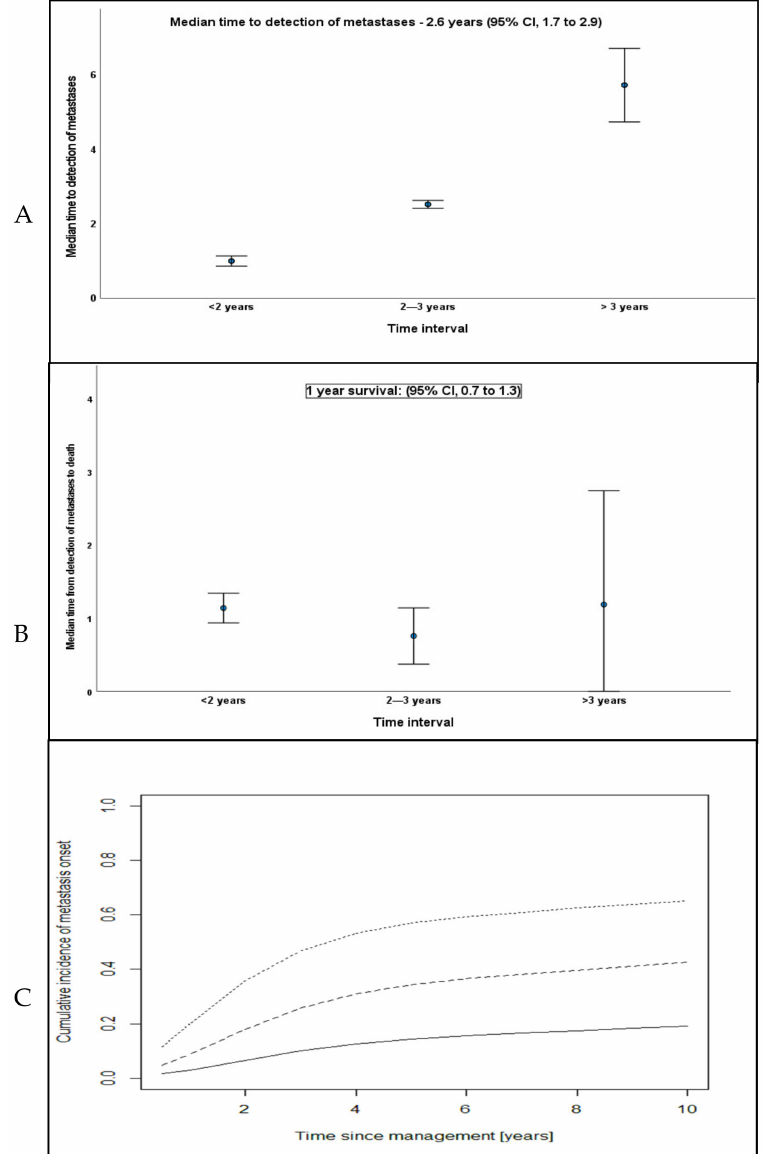
Figure 3. Bar charts with estimates for all 150 patients with metastatic UM from primary treatment to detection of metastatic disease, time from detection of metastatic disease to death, and LUMPO3-based predictions for the cumulative incidence of metastases onset. ( A ) Time from tumor management to detection of metastases for all patients. ( B ) Time from detection of metastases to death. ( C ) Expected cumulative incidences for three risk groups (by LUMPO3 prognostic index of metastatic mortality at 5 years): black line, < 0.69; dashed line, ≥ 0.69 and < 2.07; dotted line: ≥